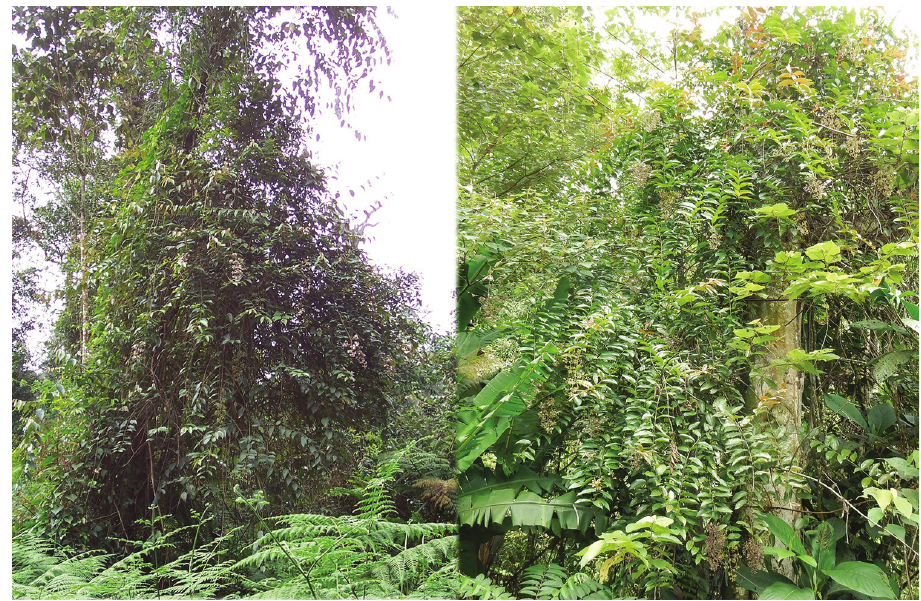
Figure 1. Habit of Dissochaeta . Photographs by A. Kartonegoro (left) and D. Penneys (right). porting, long internodes and pendent flowering and fruiting branches (Maxwell